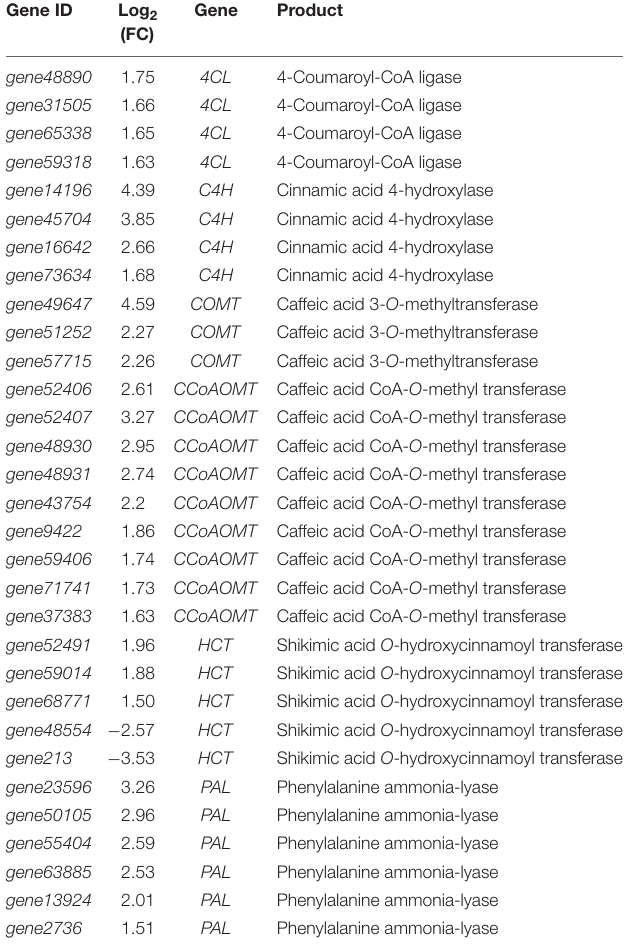
TABLE 4 | Effects of Strain YC0136 on genes related to phenylpropane compound